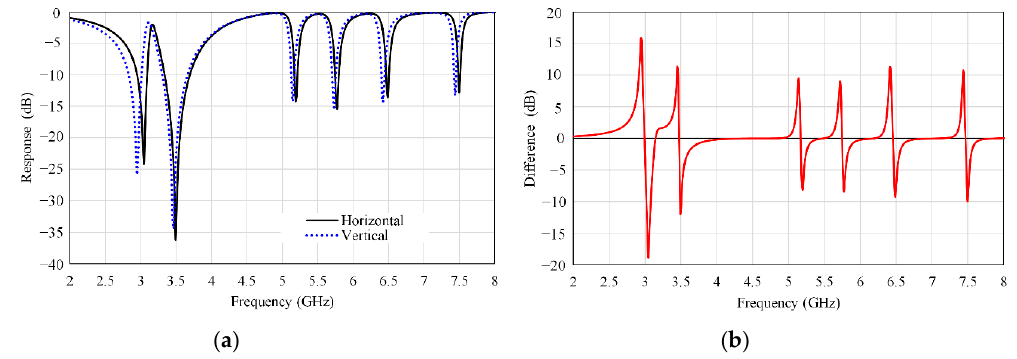
Figure 10. Code: 1010001111. ( a ) Frequency responses under excitation with vertical and horizontal polarizations. ( b ) The amplitude difference in dBs between the two responses.